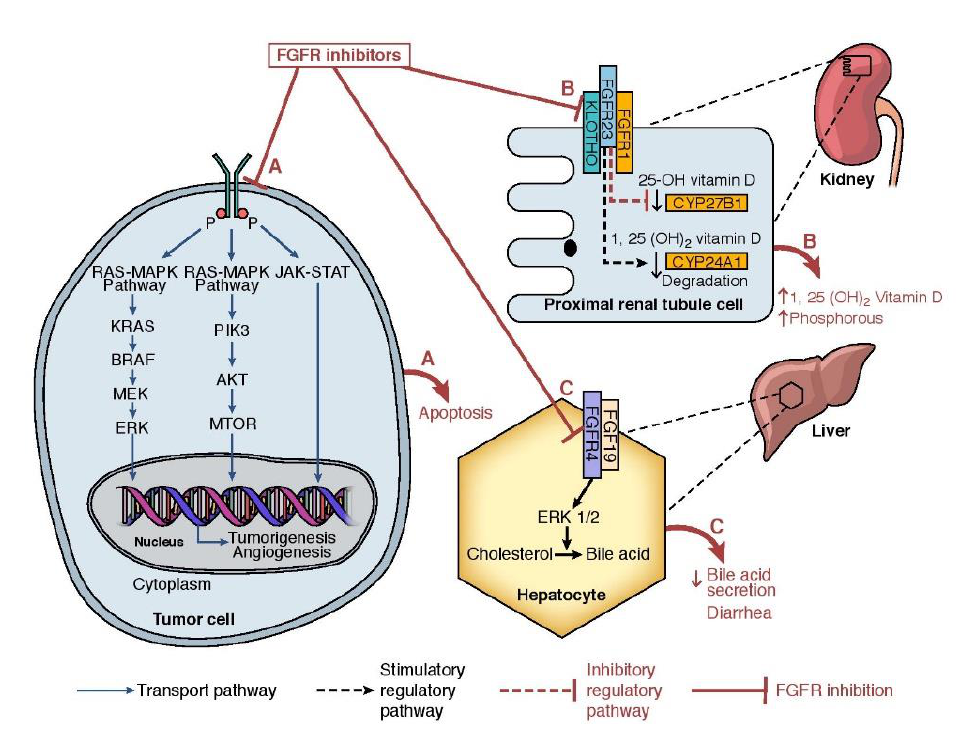
Figure 1. ( A ) Mechanism of action of FGFR inhibitors and FGFR signaling pathway: FGFR inhibitors act by inhibiting the FGFR downstream signaling pathway ( B ) Pathophysiology of FGFR-inhibitor-associated hyperphosphatemia: In kidneys, FGFR inhibitors target FGF23 ligand and FGFR1 receptor complex in the presence of klotho. Activation of the FGF23-FGFR1 pathway leads to inhibition of 25-OH vitamin D activation and degradation of 1, 25 (OH) 2 vitamin D. FGFR inhibitors block the catabolism of 1, 25 (OH) 2 vitamin D, and sodium-phosphate co-transporters in the proximal renal tubule cell thereby leading to hyperphosphatemia. ( C ) Pathophysiology of FGFR inhibitor-associated diarrhea: The FGFR4/FGF19/ERK1/2 pathway potentiates the conversion of cholesterol to bile acid in the liver. FGFR inhibitors block the conversion of cholesterol to bile acid thereby leading to altered bile acid metabolism. Table 1. Half- maximal Inhibitory Concentration (IC50) of selective FGFR inhibitors on tyrosine kinase FGF receptors. FGFR inhibitor FGFR1